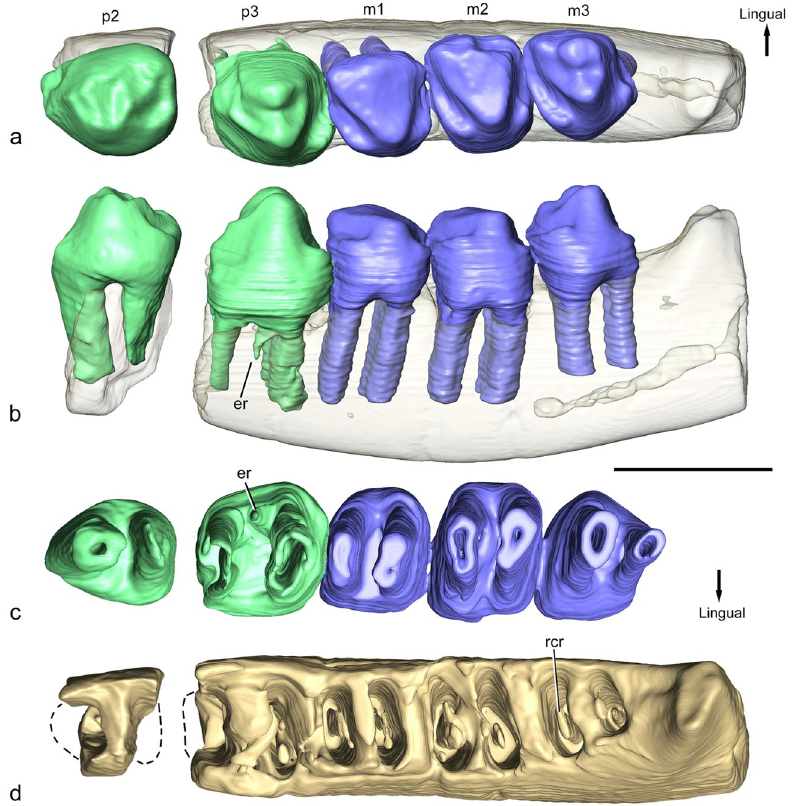
Figure 3. Orretherium tzen gen. et sp. nov. (CPAP-5007, holotype). ( a – d ) 3D-rendering of transparent partial left dentary with p2-p3 and m1-m3 in occlusal ( a ), labial ( b ) and ventral ( c ) views, highlighting the root morphology, and dentary without teeth in dorsal view ( d ). Images generated by P.H.F.M. using 3D Slicer software. er extra root, rcr radicular canal of the root. Scale bar: 5